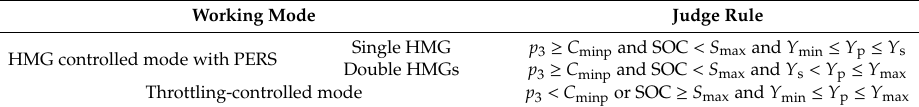
Figure 5. Overview of the control strategy of the double hydraulic motor-generator (HMG) PERS. Table 1. Decision rules of the working mode when boom